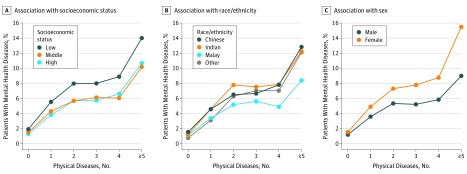
Physical and Mental Health Diseases and the Association With Socioeconomic Status, Race/Ethnicity, and SexLow socioeconomic status indicates a monthly household income of 1100 Singapore dollars (SGD) and below (for households with income), middle socioeconomic status indicates a monthly household income of 1101 to 1800 SGD (for households with income), and high socioeconomic status indicates a monthly household income of more than 1800 SGD (for households with income). (Exchange Rate as of December 31, 2016, is 1 US dollar = 1.4465 SGD).